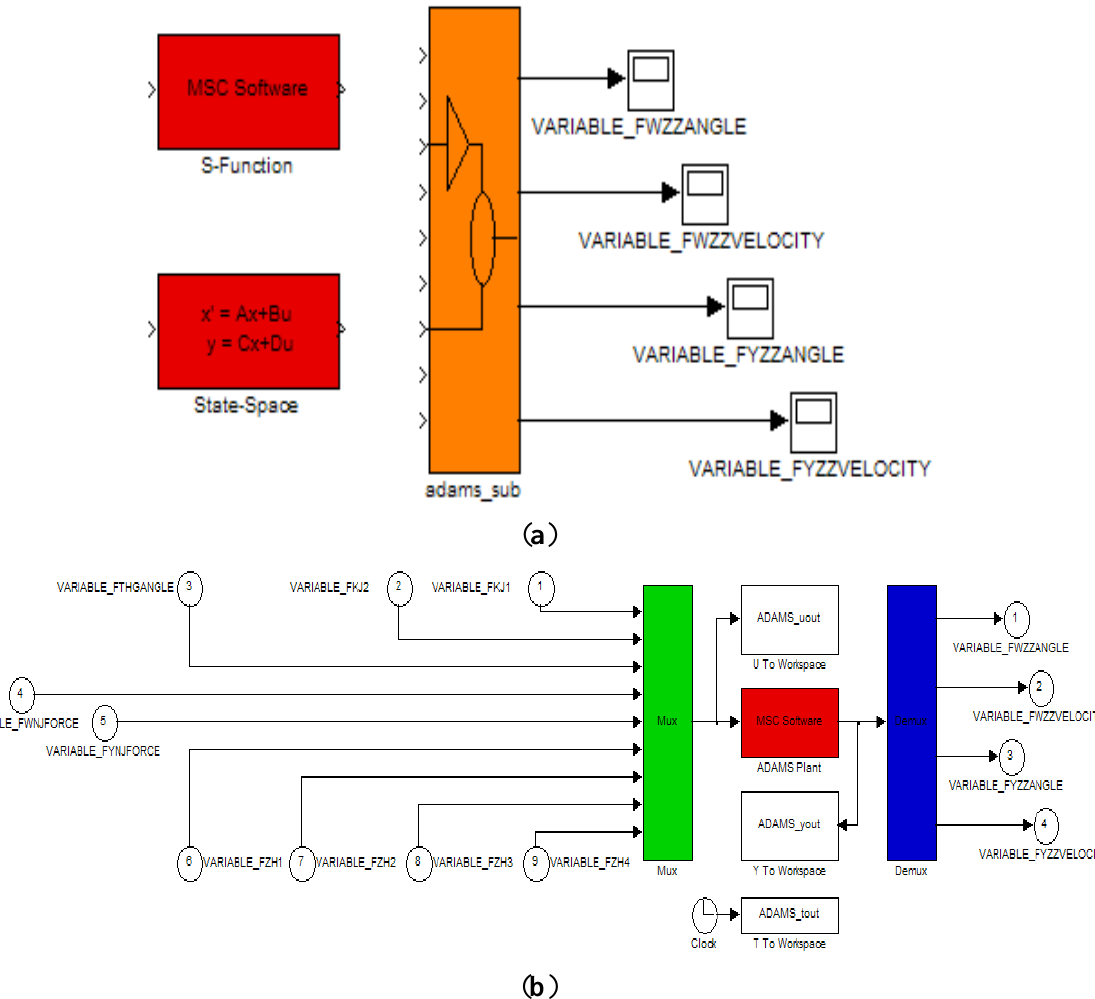
Figure 10. Co-simulation interface module of the ISP: ( a ) connection between ADAMS™ and SIMULINK ® models; and ( b ) ADAMS™ module in co-simulation